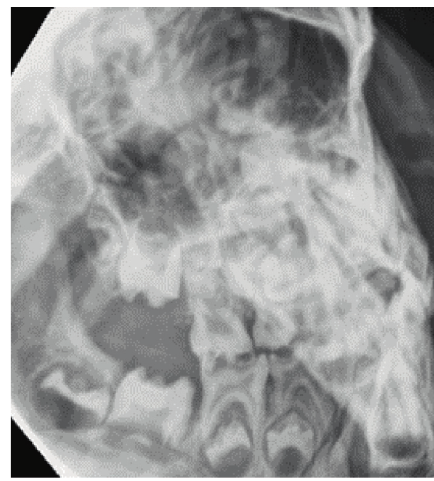
Figure 4: Gross caries experience aged